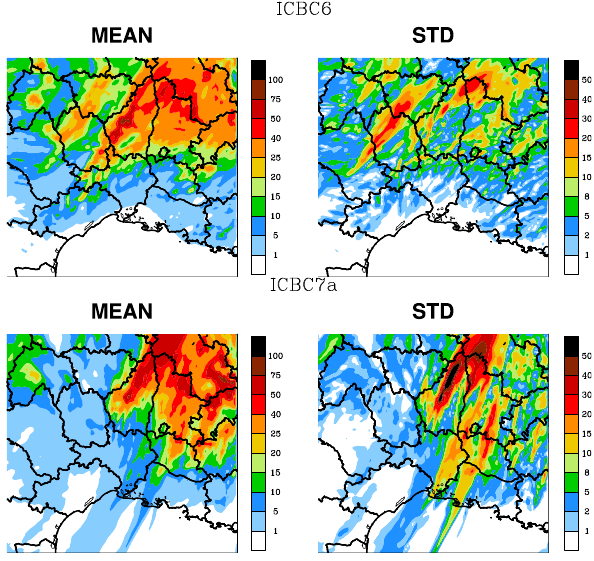
Fig. 14. The 24 h mean and standard deviation of the rainfall field for the ICBC6 (top) and ICBC7a Fig. 14. Mean and standard deviation of the 24h accumulated rain- (bottom) ensembles. fall for the ICBC6 (top) and ICBC7a (bottom) 39